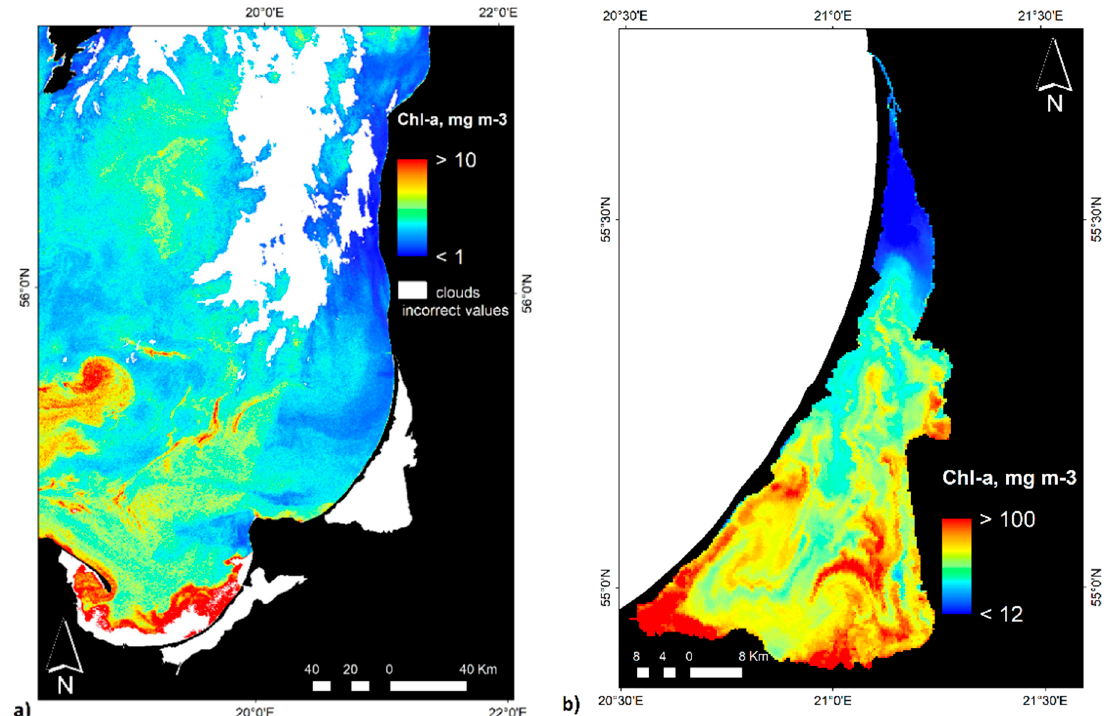
Figure 14. Spatial distribution of the chl-a concentration during the major upwelling event, as retrieved from MERIS/Envisat (Medium Resolution Imaging Spectrometer onboard the Envisat satellite, European Space Agency) ( a ) in the Baltic Sea coastal waters ( b ) and in the Curonian Lagoon on 17 July 2006.